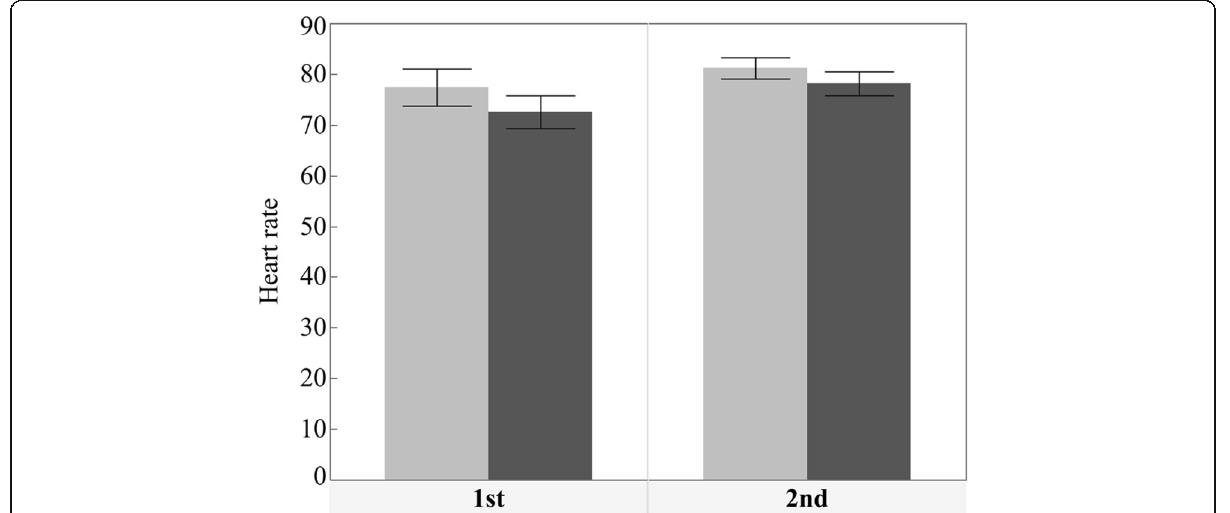
Fig. 2 Bar chart showing the mean HR scores before and after operation